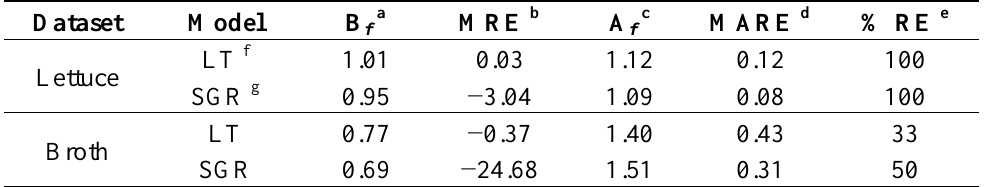
Table 3. Performance of secondary growth models for a mixture of E. coli O157:H7 NT in blanched spinach for extrapolation.